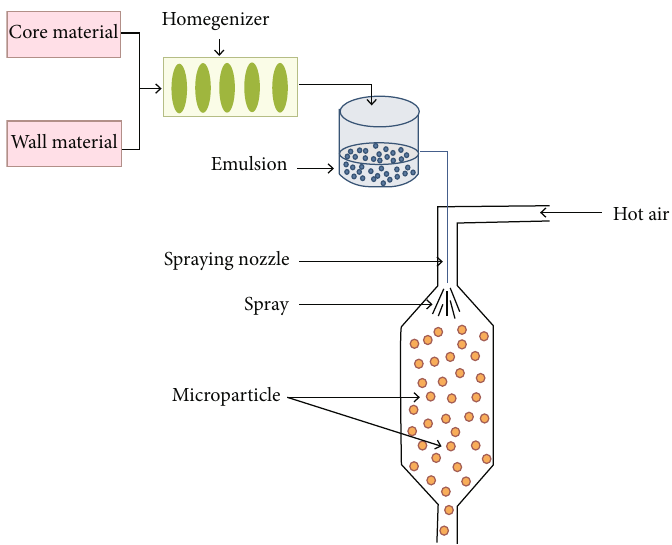
Figure 24: Schematic representation of the microencapsulation process by spray drying [90].